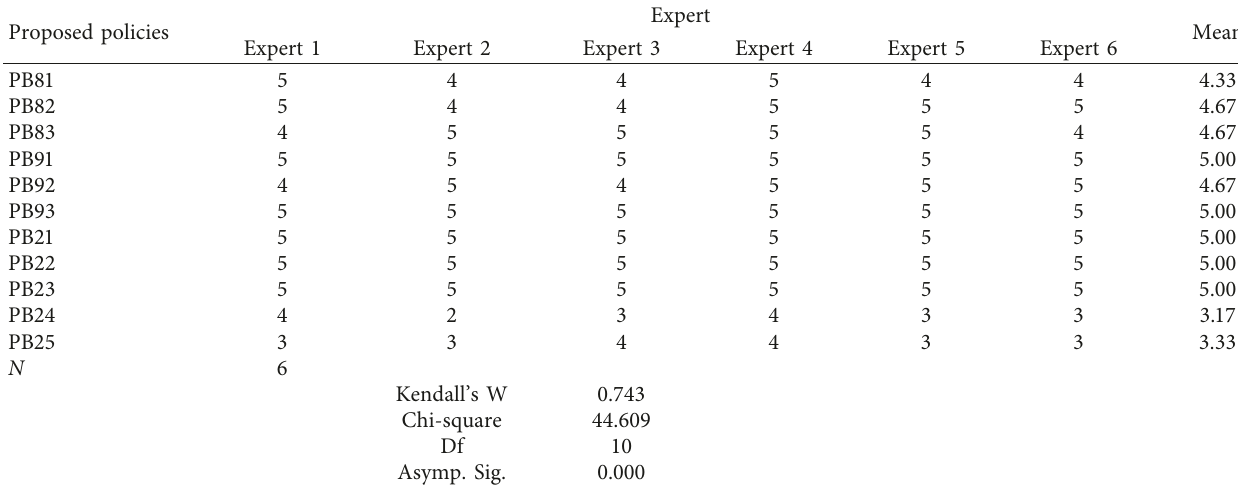
Table 13: Second rounds of the Delphi